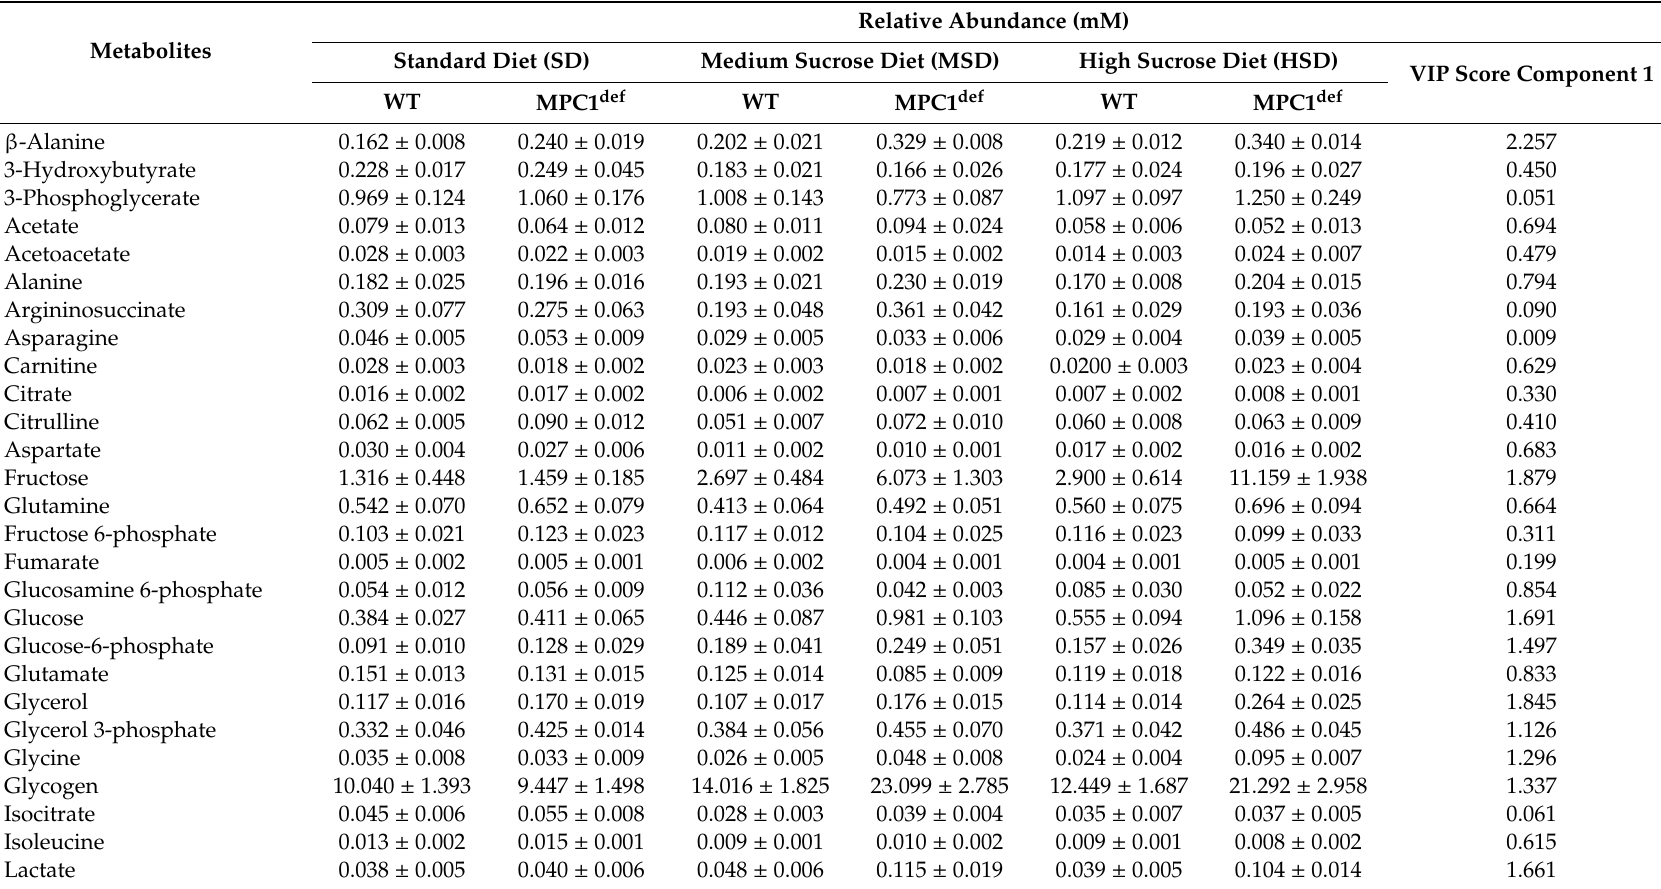
Table 2. Relative metabolites abundance and ascribed VIP scores assigned with PLS-DA on component 1 identifying the metabolites driving the separation and / or clustering among Drosophila melanogaster WT and MPC1 def exposed to the experimental diets (SD, MSD, or